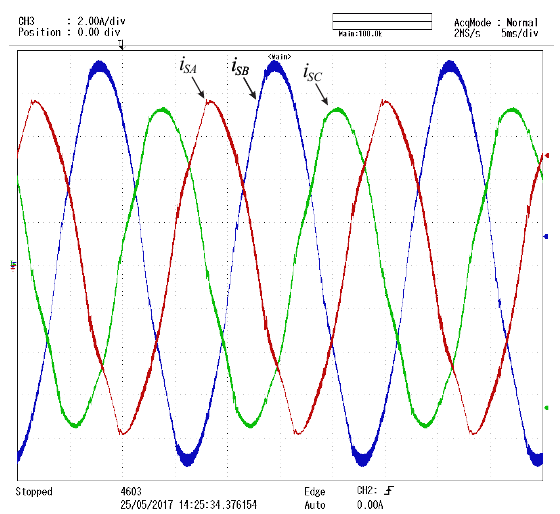
Figure 13. Three-phase grid current waveforms with the DHPF-NSI enabled.